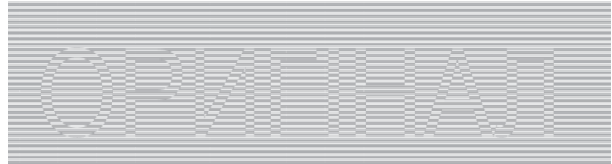
Figure 5. Hidden inscription "ОРИГІНАЛ" formed by the displacement of raster lines in the second raster field.